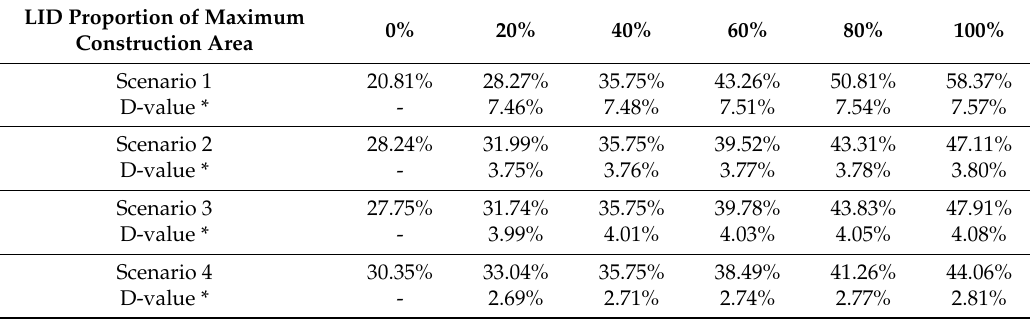
Table 7. Reduction rates of runoff in various LID scenarios.